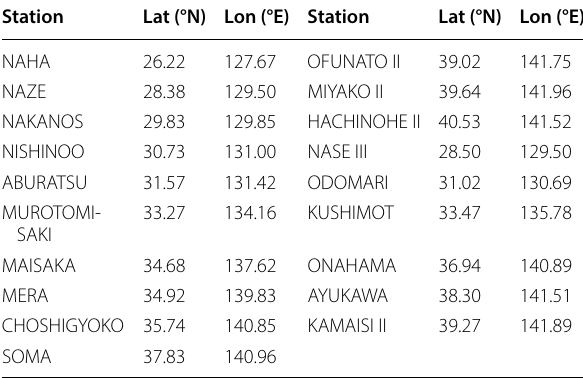
Table 1 Tide gauges’ locations along the western boundary of the North